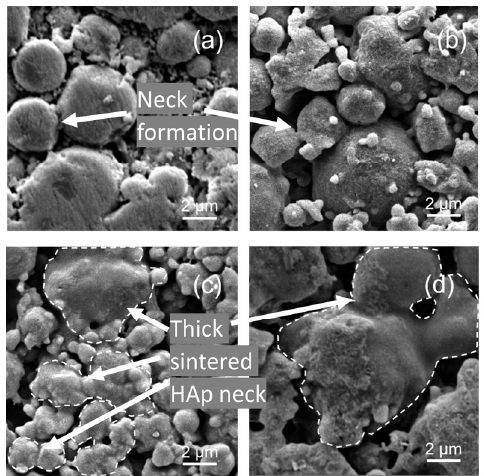
Figure 6. Micrographs of sintered MK/HAp ceramic specimens: ( a ) HM10-1.25, ( b ) HM20-1.00, ( c ) HM30-1.25 and ( d ) HM30-1.50.